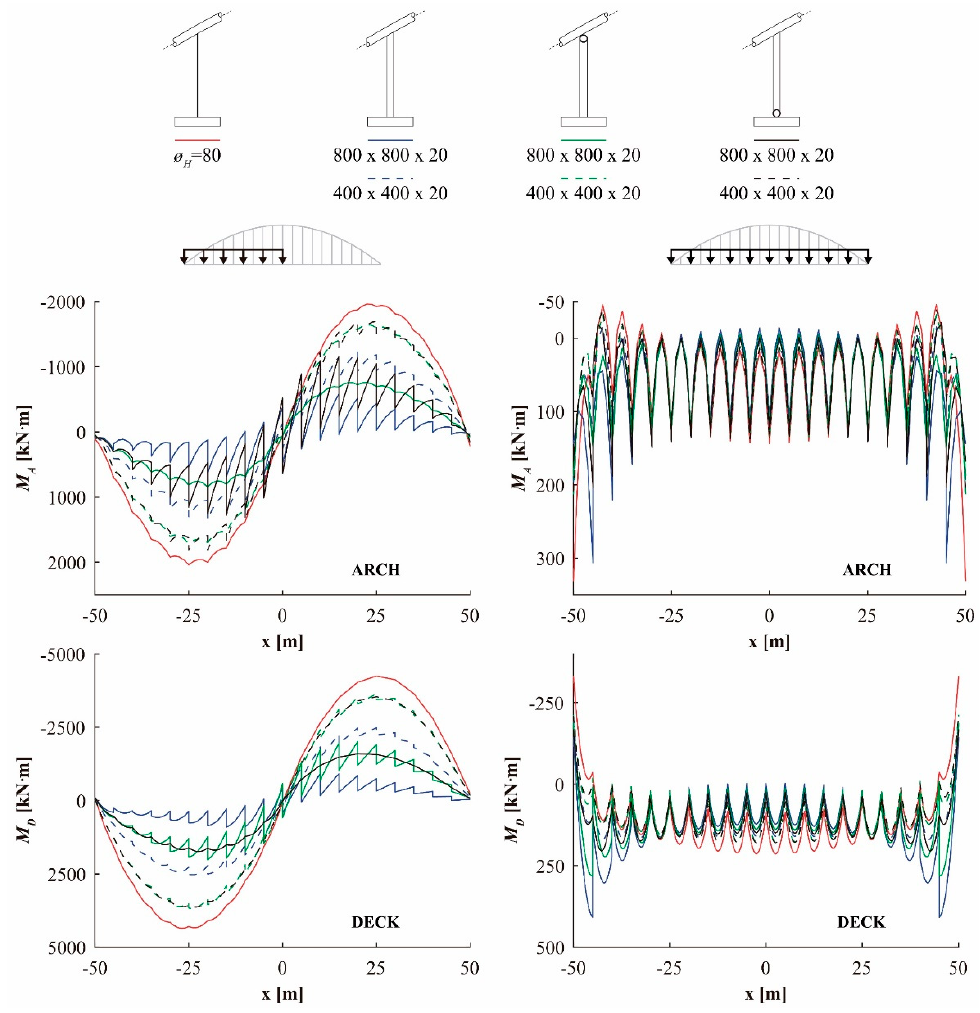
Figure 11. Effect of the hanger stiffness: bending moment distribution at the arch and deck.